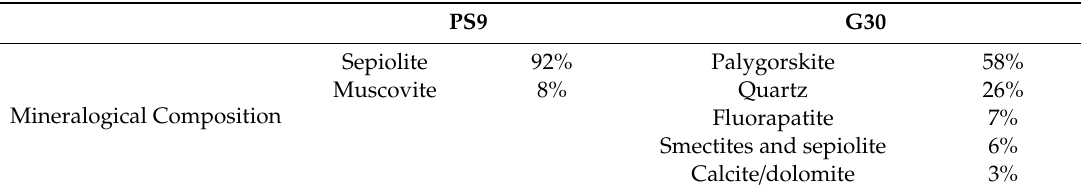
Table 1. Fibrous clay (PS9 and G30) mineralogical composition (modified from [63]). PS9 G30 Sepiolite 92% Palygorskite 58% Muscovite 8% Quartz 26% Mineralogical Composition Fluorapatite 7% Smectites and sepiolite 6% Calcite / dolomite 3%